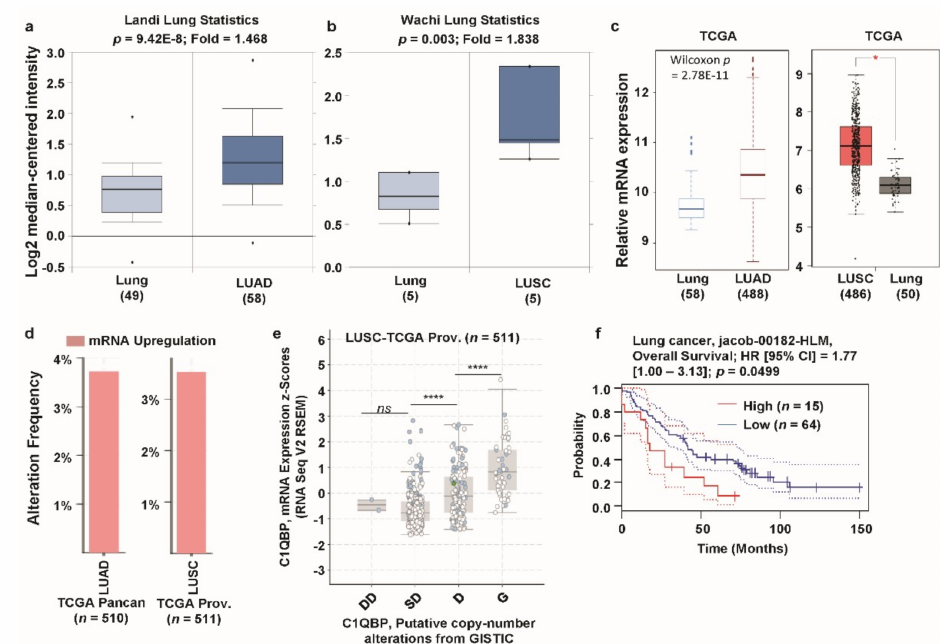
Figure 3. C1QBP expression pattern and patient survival analysis in lung cancer: comparison between C1QBP expression in normal tissue and cancer tissue. ( a ) The fold-change of C1QBP in lung cancer was identified by our analyses, shown as a box plot. The box plot comparing specific C1QBP expression in normal ( n = 49, left plot) and cancer tissue ( n = 58, right plot) was derived from the Oncomine database. The analysis compared expression in LUAD, relative to expression in normal lung. The asterisk above and below the box represent maximum and minimum value, respectively. ( b ) The fold-change of C1QBP in lung cancers was identified by our analyses, shown as a box plot. The box plot comparing specific C1QBP expression in normal ( n = 5, left plot) and cancer tissue ( n = 5, right plot) was derived from the Oncomine database. The analysis shown is of the expression in LUSC relative to that in normal lung. ( c ) Expression of C1QBP gene in The Cancer Genome Atlas (TCGA) database. Box plots showing the C1QBP mRNA expression in LUSC tumor (T, red plot) and the corresponding normal (N, gray plot) tissues, using data from the TCGA database through TCGA Wanderer and GEPIA. *: p < 0.01. ( d ) Alterations (mRNA upregulation) of the C1QBP gene in LUAD (TCGA PanCanAtlas; n = 510) and LUSC (TCGA Provisional; n = 511). Data was obtained using cBioPortal. ( e ) C1QBP mRNA expression was significantly associated with the copy number alteration status (ANOVA, p < 0.0001) in lung cancer. (****: p < 0.0001; ns : nonsignificant) ( f ) The survival curve comparing patients with high (red) and low (blue) expression in lung cancer was plotted from the PrognoScan database. Survival curve analysis was conducted using a threshold Cox p -value < 0.05. Abbreviations. LUAD: lung adenocarcinoma; LUSC: lung squamous cell